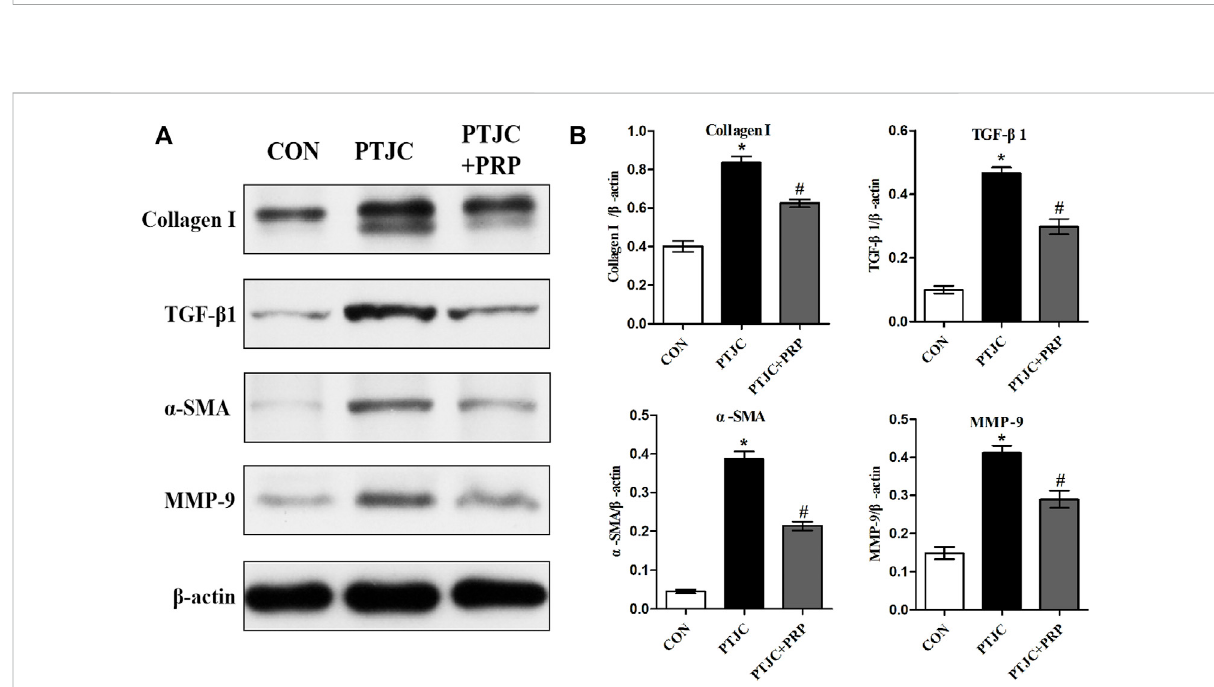
FIGURE 5 Expression of fi brosis-associated proteins in the posterior joint capsule were assessed via western blot. (A) The western blot analysis of COL- Ⅰ , TGF- β 1, α -SMA, MMP-9 in the posterior jointcapsule. (B) The bar graphs represent the relative expression of these proteins after normalization to β - actin. Error bars represent standard deviation. * p < 0.05 compared with the CON group. # p < 0.05 compared with PTJC